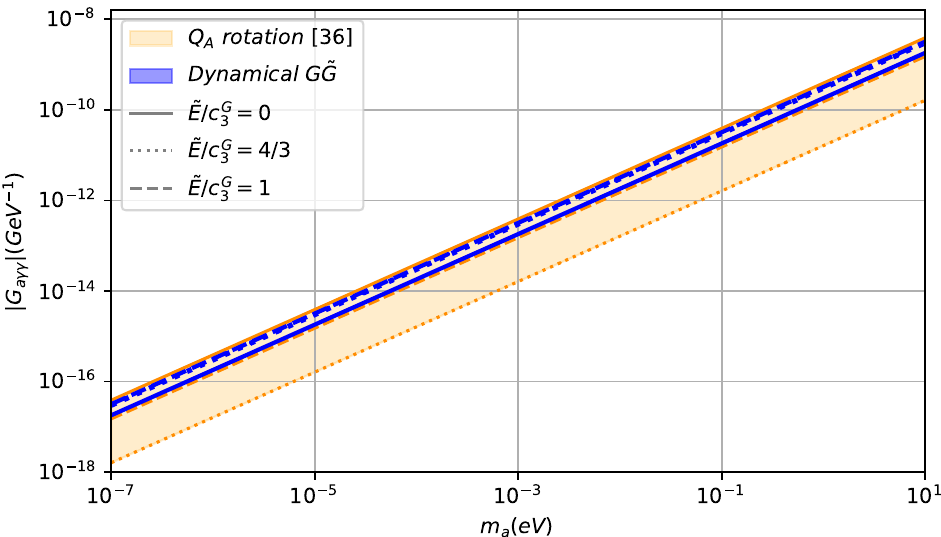
parameter to the canonical E/N 3 = 0 . 5( E/N ) , and we show three 3